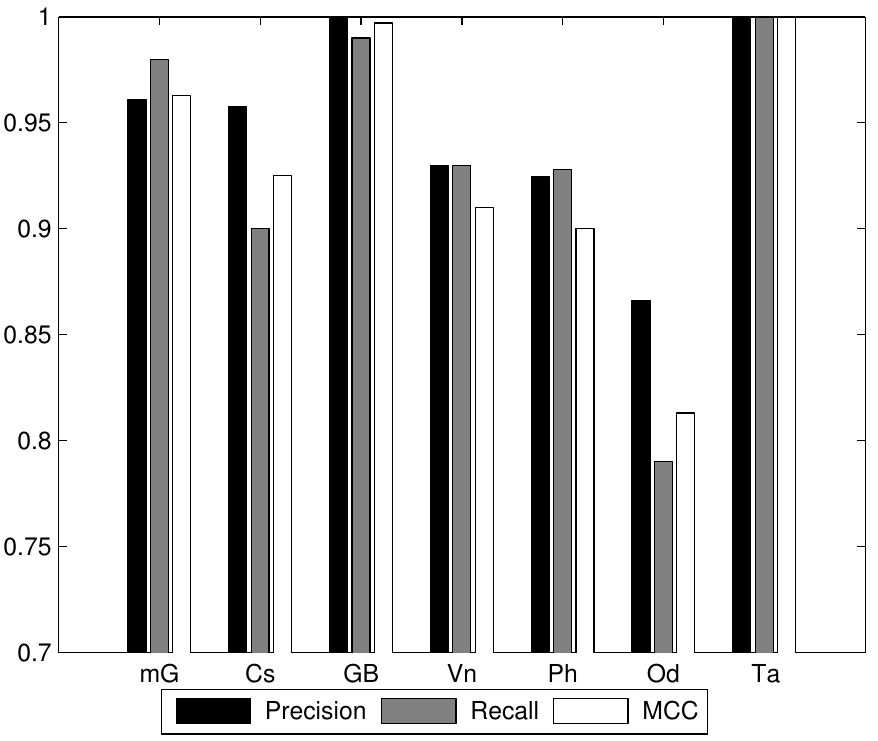
Figure 2: Graphical representation of the Precision, Recall and MCC per subfamily, for the AAA